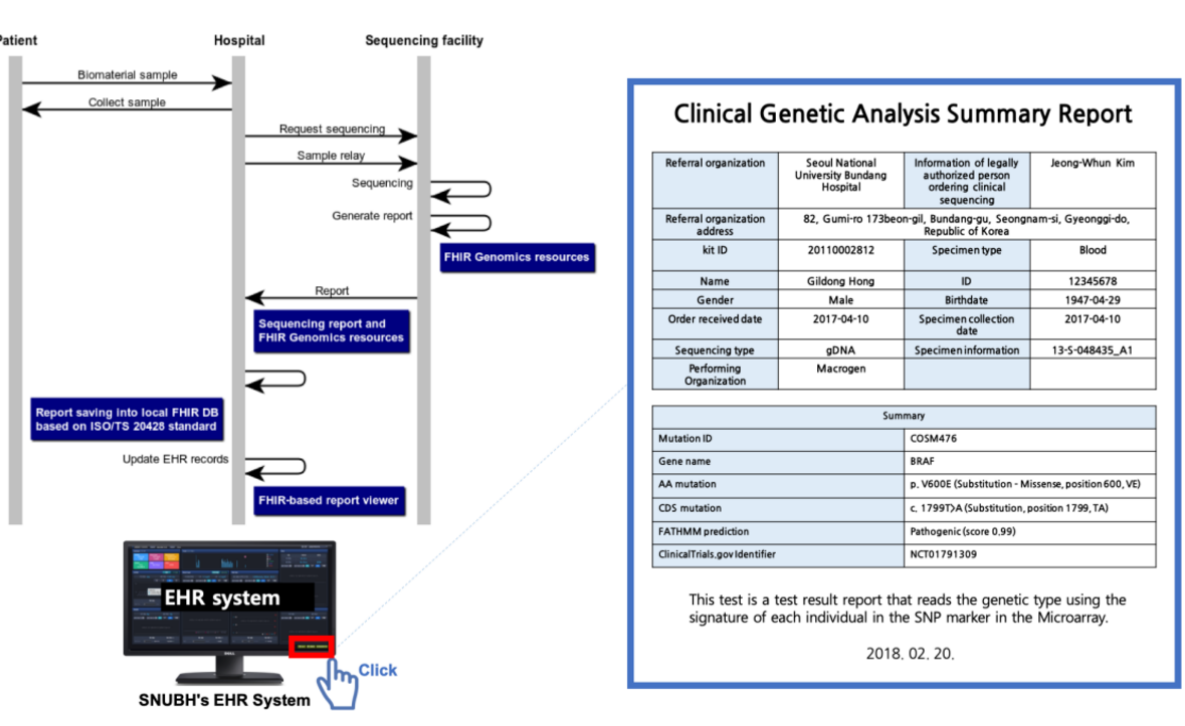
Figure 1. Implementation of the clinical next generation sequencing (NGS) report viewer. DB: database; EHR: electronic health record: FHIR: Fast Healthcare Interoperability Resources; ISO/TS: International Organization for Standardization Technical Specification; SNP: single nucleotide polymorphism; SNUBH: Seoul National University Bundang